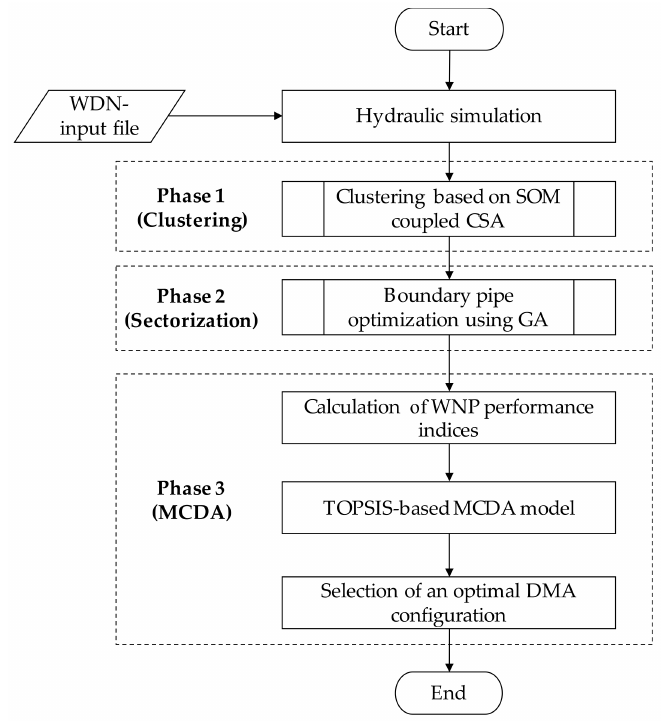
Figure 1. Flow chart of the proposed approach.